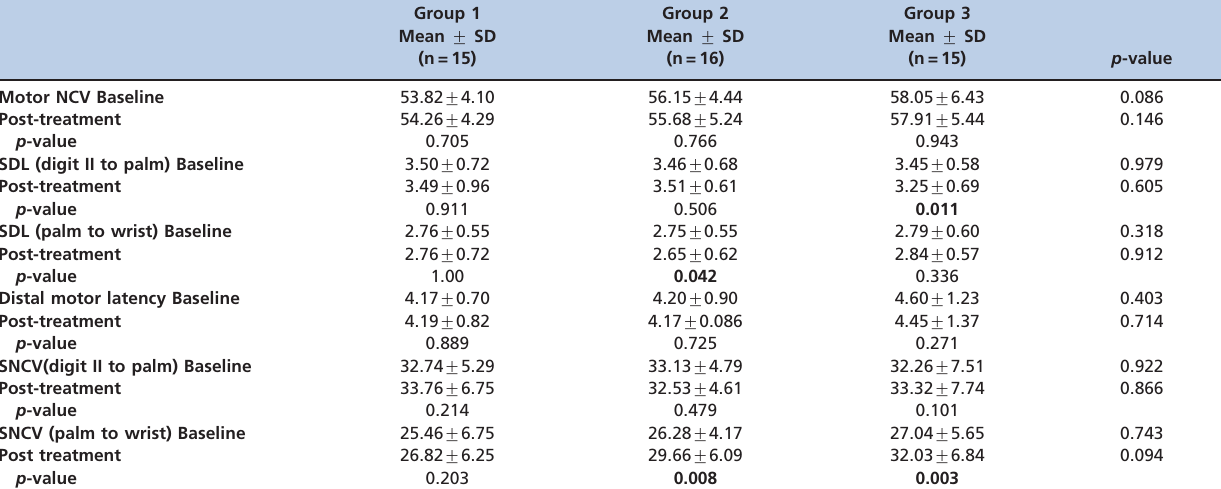
Table 3 - Comparison of electrophysiological parameters at baseline and at the end of the treatment